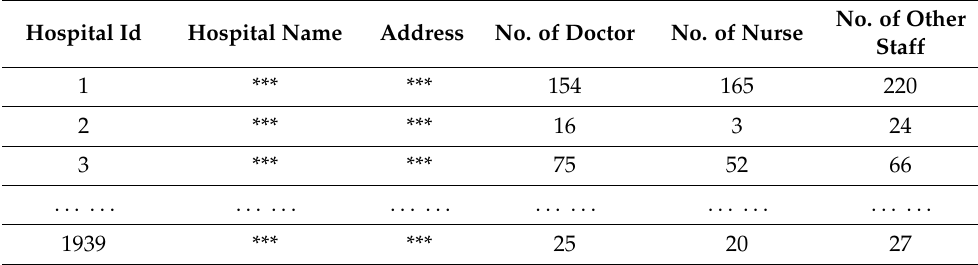
Table 1. Dataset about hospital information.